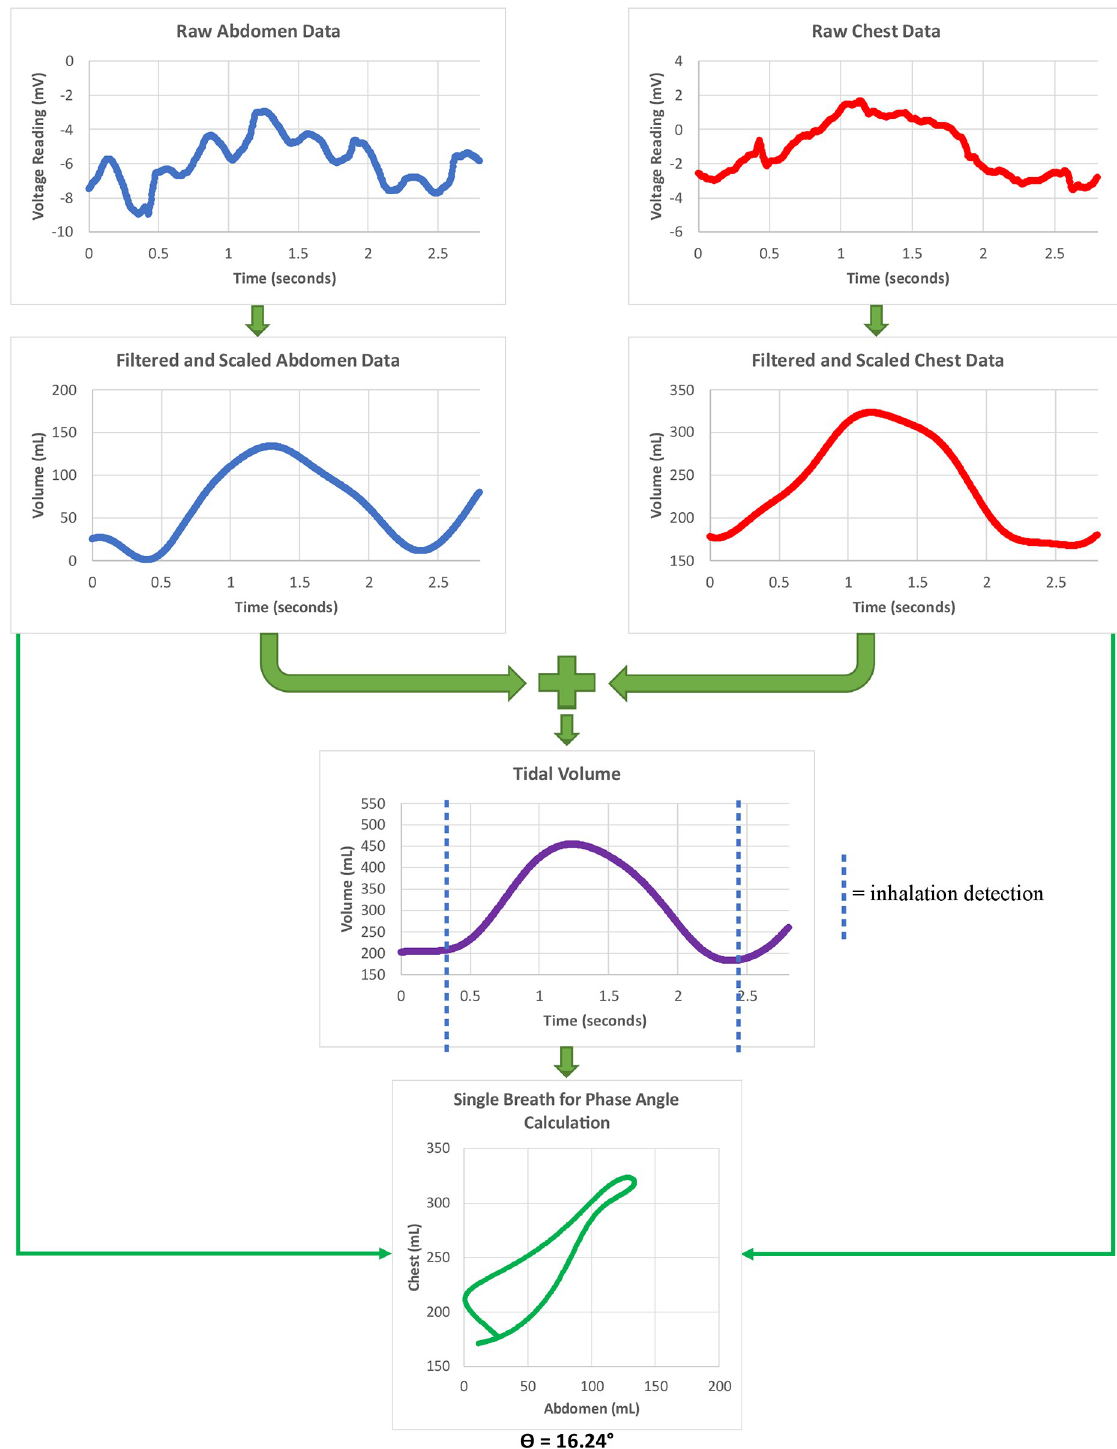
Fig 5. The process used by VivoSense to calculate phase angle for each breath. The entire process undergone by raw chest and abdomen data to calculate phase angle for a single breath.